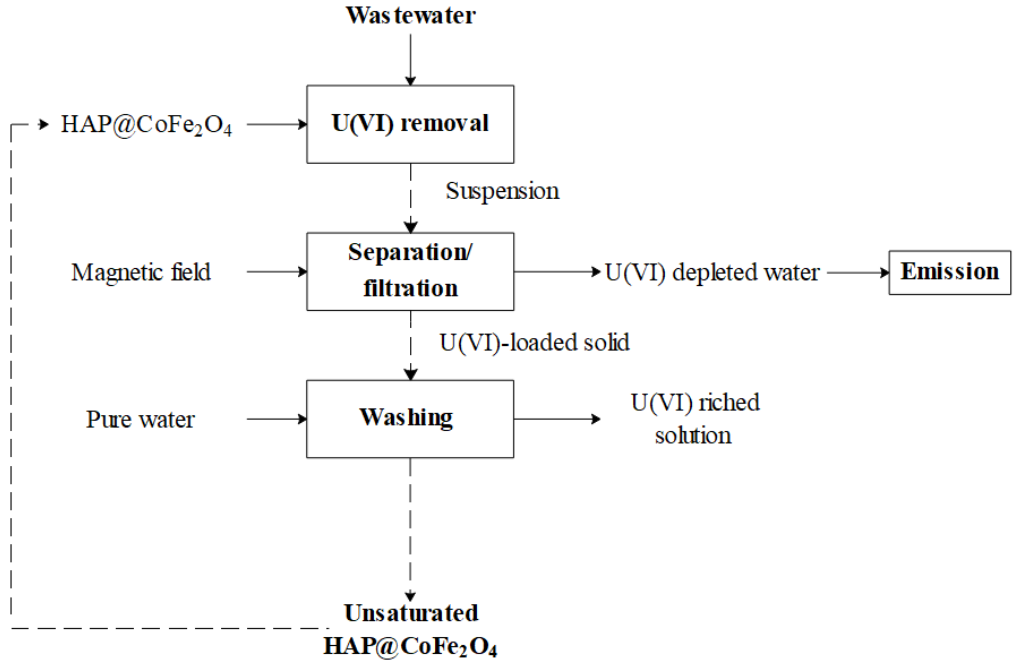
Figure 6. Schematic of the removal of U(VI) using HAP@CoFe 2 O 4 . The dashed lines present the solid phases.